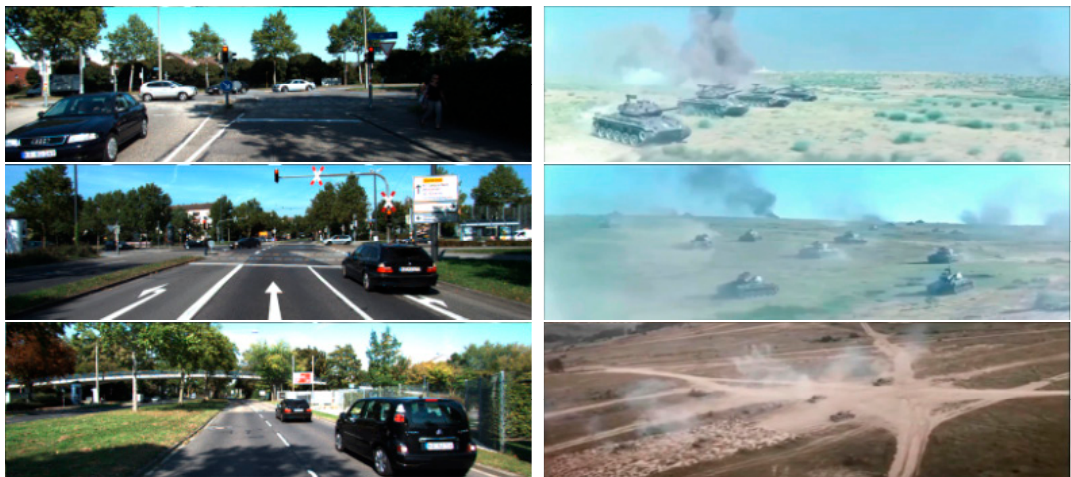
Figure 1. Typical frames including vehicles in KITTI tracking benchmarks and armored targets from our Armored Target Tracking Dataset